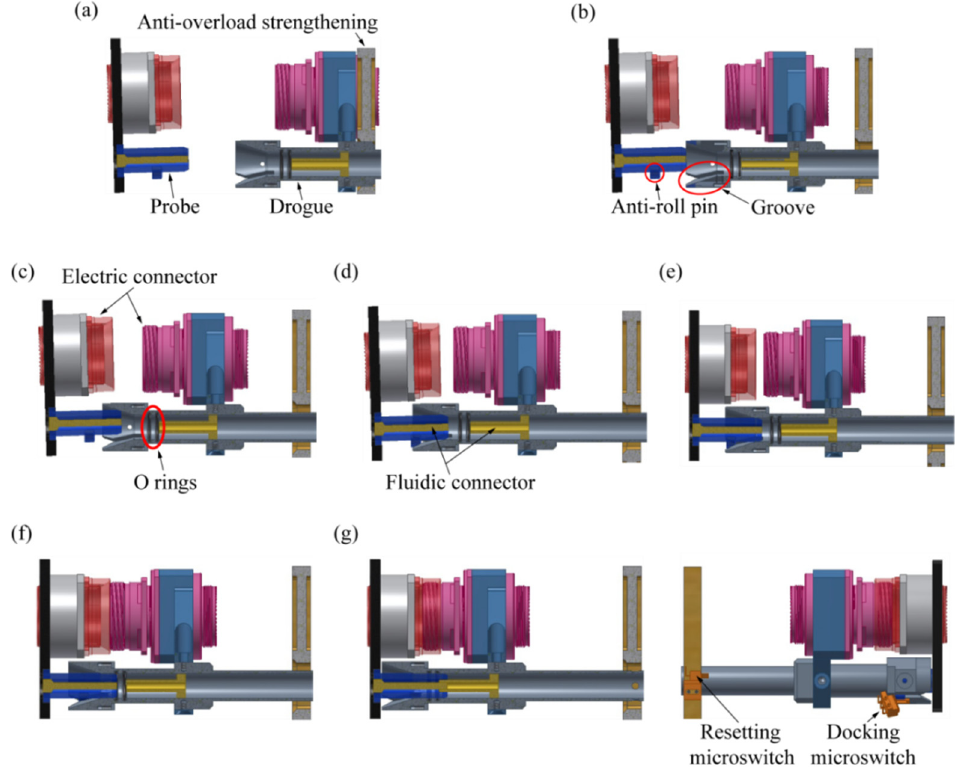
Figure 8. The process of docking: ( a ) initial, ( b ) approach, ( c ) contact and alignment I, ( d ) probe inser- tion and alignment II, ( e ) pin insertion and alignment III, ( f ) connector docking, ( g )